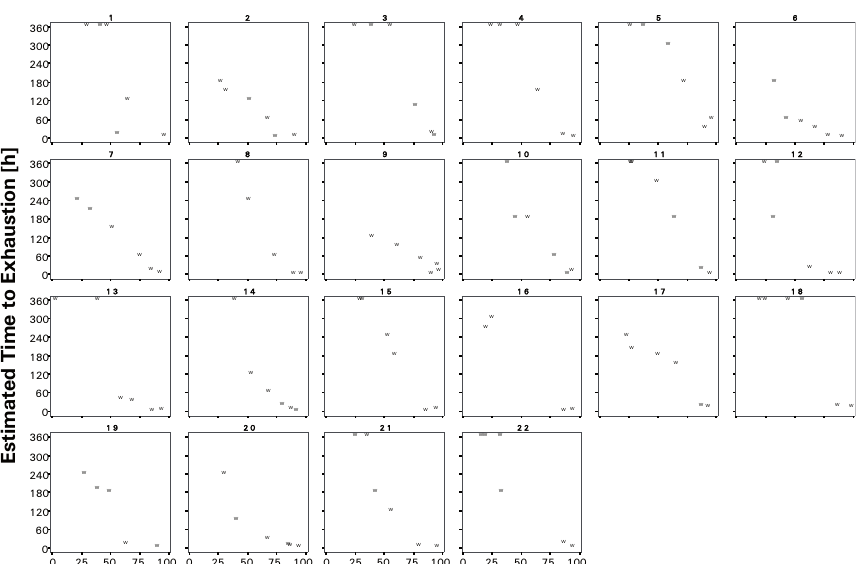
Figure 4 Muscular, respiratory and overall exhaus- tion in relation to oxygen uptake [per- cent personal best] in 22 healthy control subjects. Each panel represents the results of an individual test person. Subjectively rated markers of exhaustion showed a relevant interindi- vidual variability.